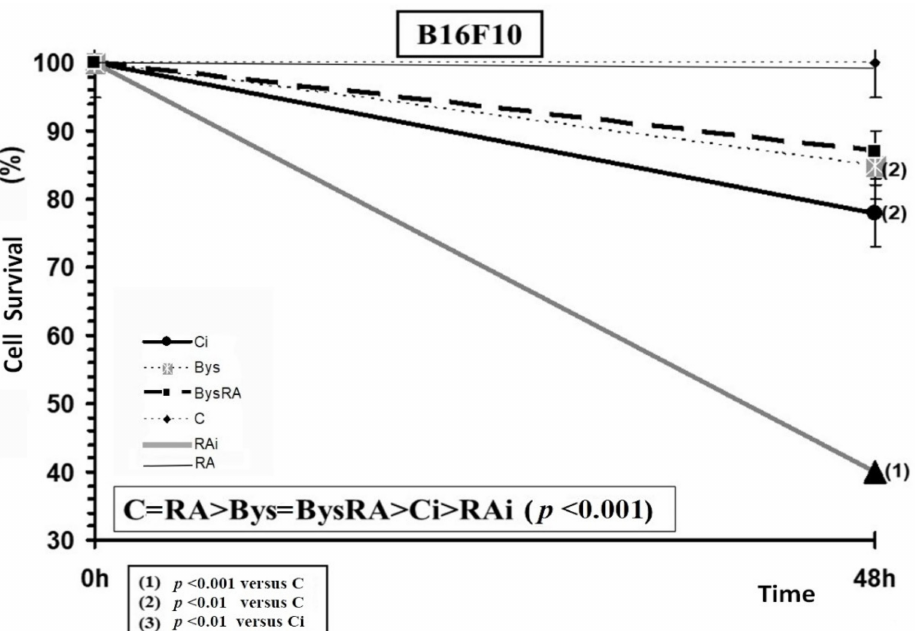
Figure 8. Cell survival of B16F10 cells irradiated to 20 Gy of X-rays after 48 h of incubation (C, control; RA, treated with rosmarinic acid; Ci, irradiated control; RAi, irradiated, previously treated with rosmarinic acid; Bys, treated with the medium of irradiated cell culture; BysRA, treated with the irradiated cell culture medium and rosmarinic acid). Data are the mean and standard error of eight independent